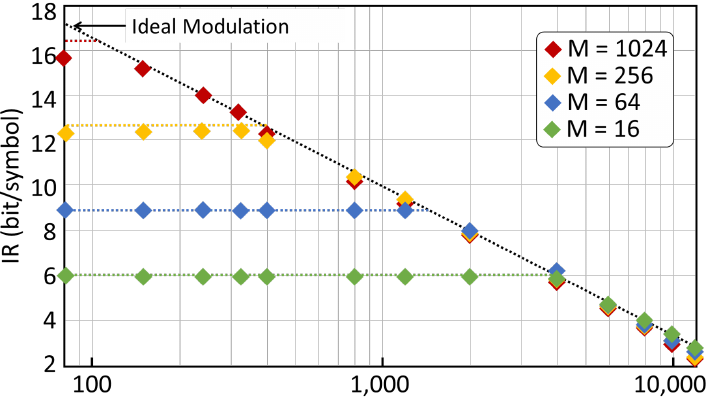
Figure 6. Experimental data from [74] for probabilistically shaped M-QAM signals. Symbols corre- spond to measured points. Dashed lines correspond to a linear